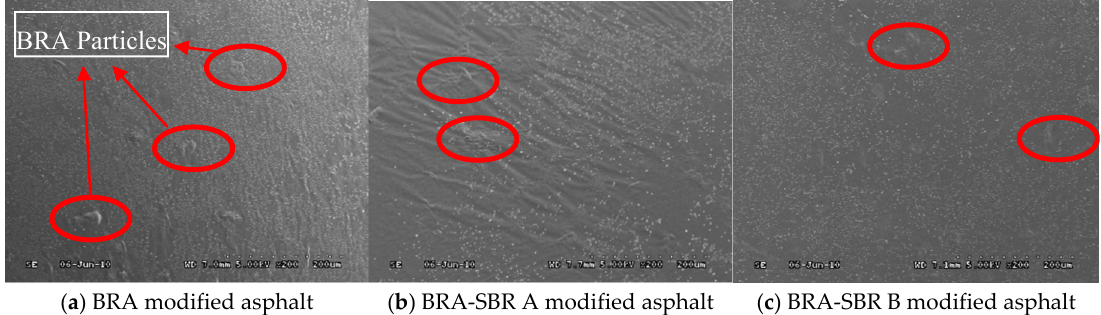
Figure 10. Scanning electron microscope (SEM) images of BRA modified asphalt before and after modifying by SBR